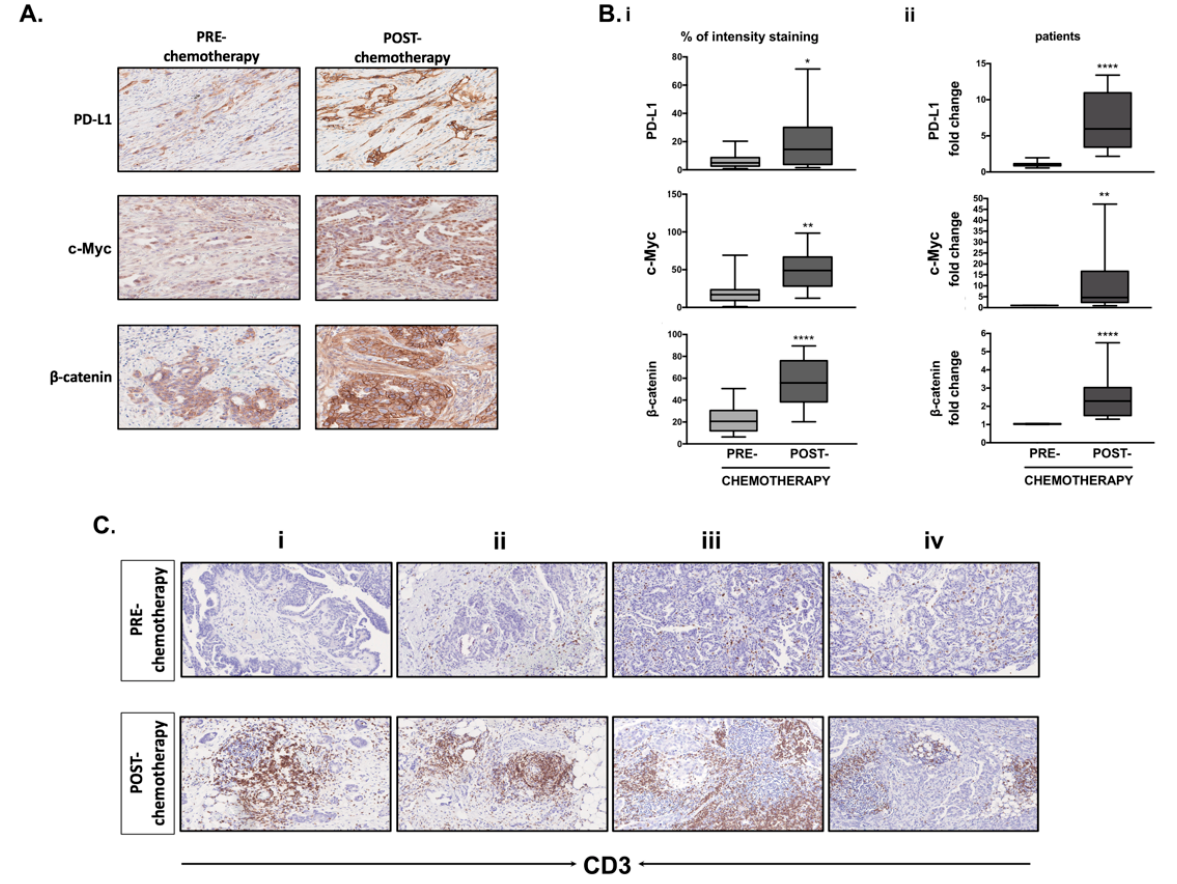
Figure 8. PD-L1, c-Myc, β -catenin expression and CD3+T cell infiltration increases in EOC patients’ biopsies after chemotherapy. ( A ) Formalin-Fixed Paraffin-Embedded (FFPE) tissue sections from all OC patients’ biopsies were immunoassayed for PD-L1, c-Myc and β -catenin staining using an automated Bench Mark Ultra (Ventana, Monza, Italy). One out of four representative images (Patient C) is shown. After extended antigen retrieval by heat-induced antigen retrieval (HIER), detection of the three proteins was performed with Ventana primary antibodies, using (3,3 ′ -diaminobenzidine) (DAB) as chromogen. Deposition of brown staining reveals the presence of each protein. The stained tissue sections were digitalized at a 20× magnification using a NanoZoomer Digital Slide Scanner. ( B ) ( i ): The percentage of intensity staining for each protein was evaluated by counting the total PD-L1, β -catenin and c-Myc positive cells (neoplastic and stromal cells) in three squared areas from each clinical sample, using ImageJ. The % of immunostaining intensity from four biopsies pre- and post-chemotherapy was graphically calculated as a mean of four samples. Two tailed unpaired t test demonstrated the statistically significant differences among pre- and post-chemotherapy biopsies, * p < 0.05, ** p < 0.01, **** p < 0.0001. ( ii ): RT-qPCR analysis of PD-L1, c-Myc and β -catenin transcripts was done by pooling together all the biological replicates from the five patients. Each graph represents the mean standard deviation of c-Myc and β -catenin fold change, normalized